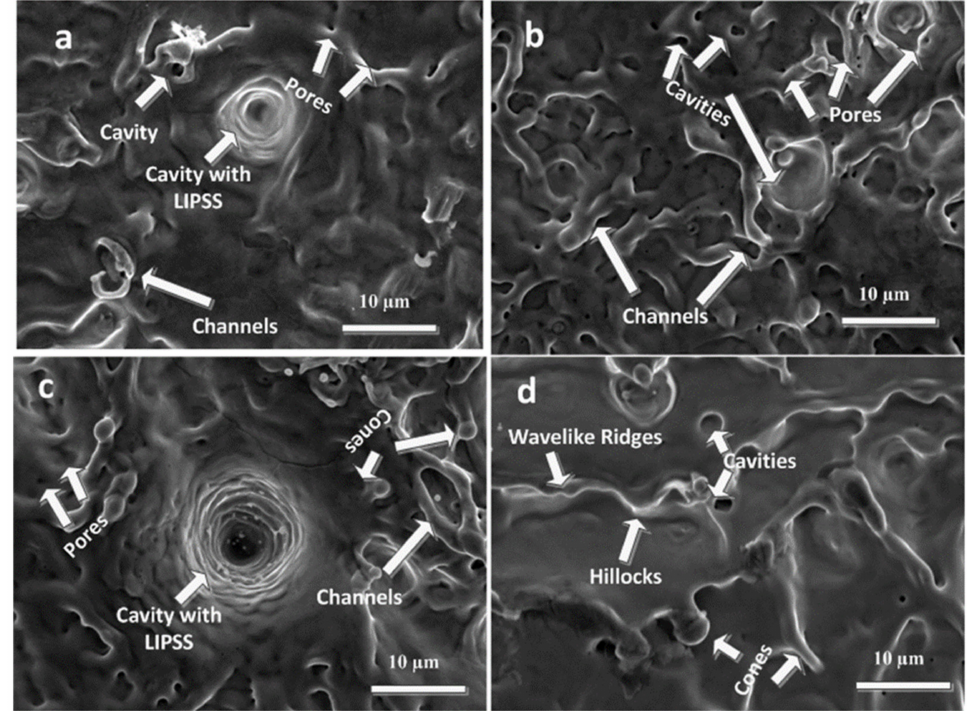
Figure 5. SEM topographical images at periphery of laser-ablated areas of cd targets using SEM analysis for ( a ) 500, ( b ) 1000, ( c ) 1500 and ( d ) 2000 laser pulses, at constant fluence of 3.6 J cm − 2 in propanol.